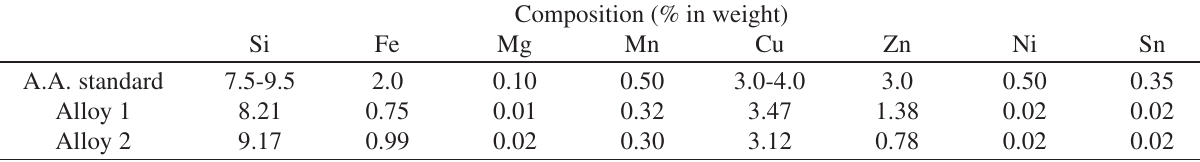
Table 2. Chemical compositions of 380 aluminum alloys.